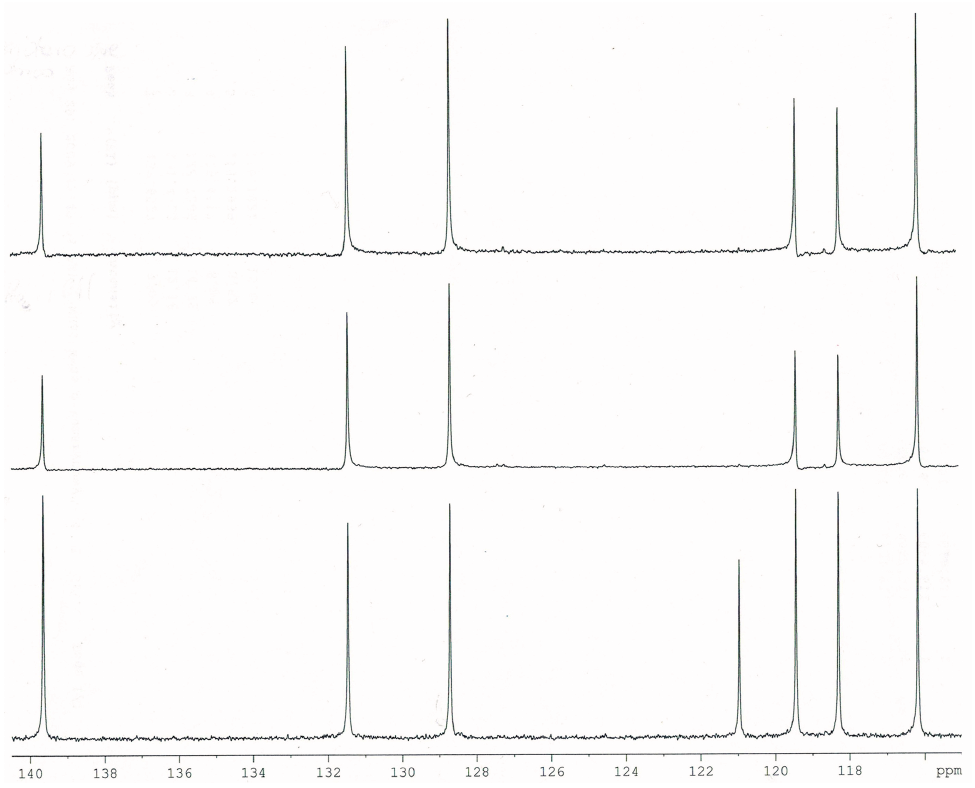
Figure 5. Experimental DEPT NMR spectrum of trans o- coumaric